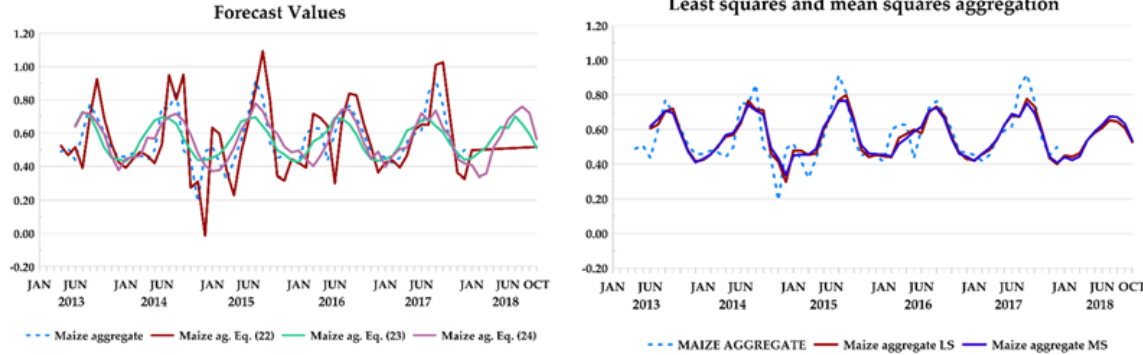
Figure 12. Forecast values for one-year time horizon given by the estimation models presented in Equations (22)–(24) and least squares and mean squares aggregation models.